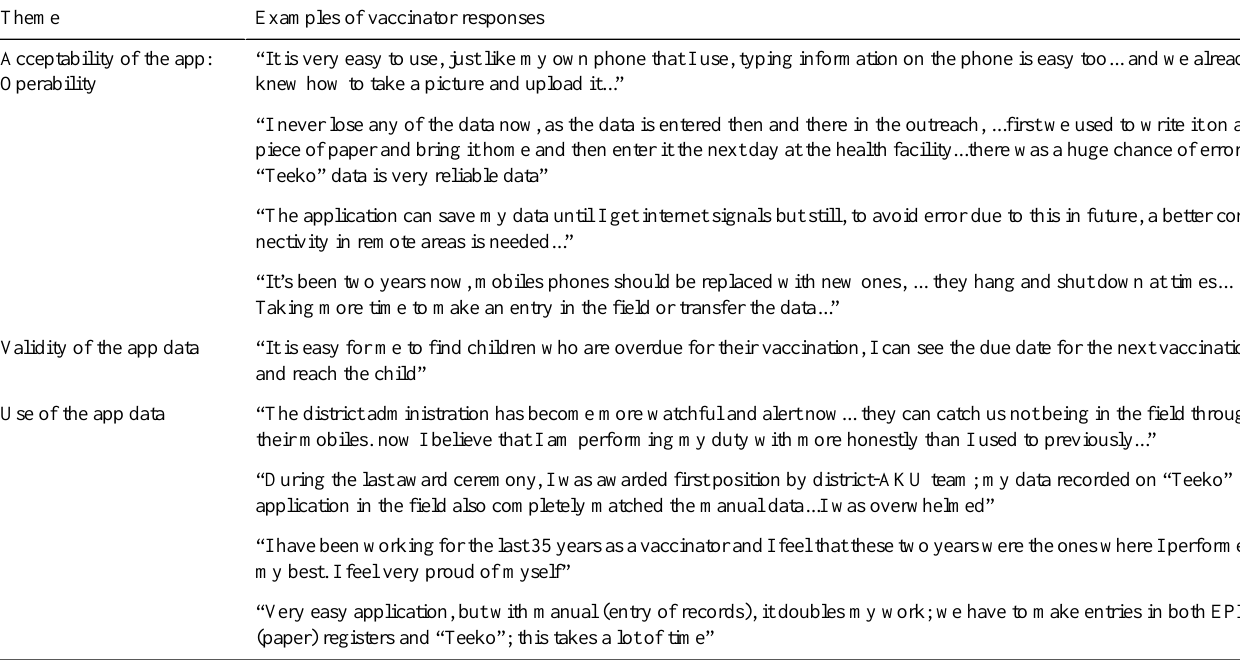
Table 3. Specific responses from the vaccinator interviews, organized by theme. Examples of vaccinator